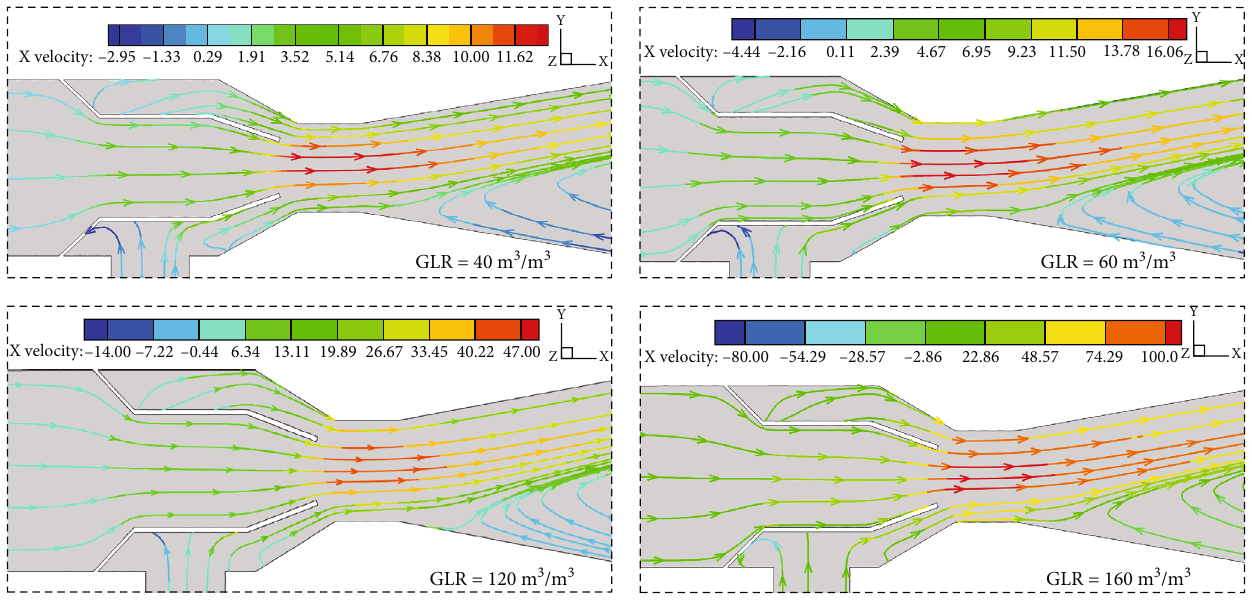
Figure 11: Streamline diagram of the ejector.